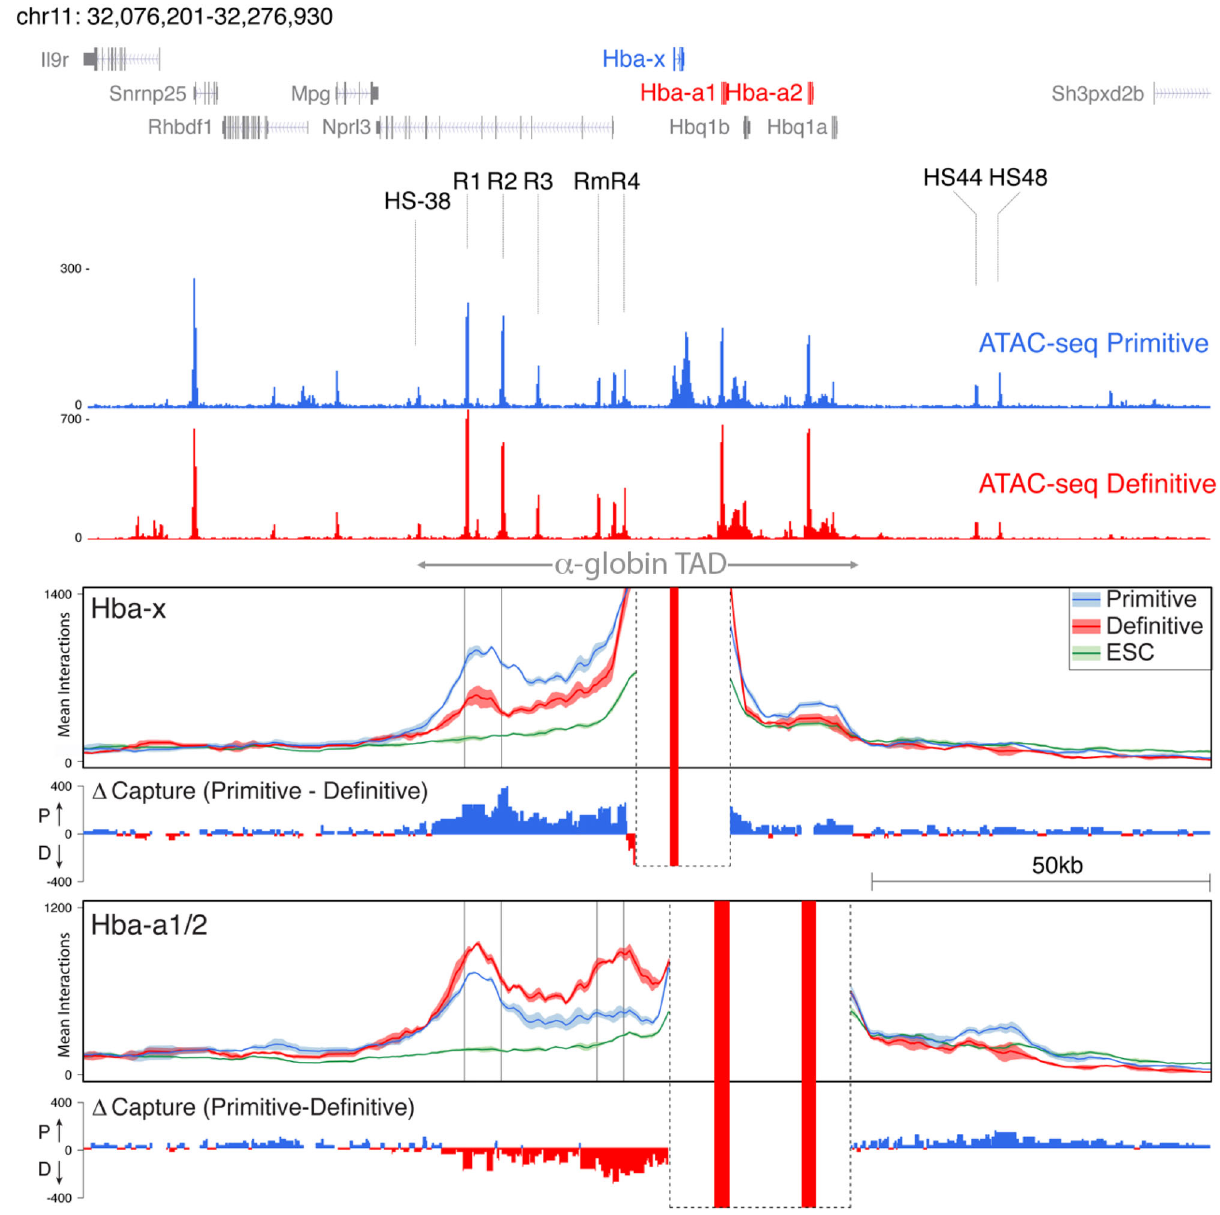
Fig. 4 The ζ -globin gene remains in proximity to the α -globin superenhancer in de fi nitive erythropoiesis. Normalized Capture-C data from the viewpoint of the Hba-x promoter and the Hba-a1/2 promoter (lower panels), ATAC-seq tracks are shown above for orientation. The mean, plus and minus one standard deviation (s.d.), of sliding 5 kb windows are visualized. Differential tracks ( Δ Capture-C) show a subtraction (Primitive − De fi nitive) of the mean number of meaningful interactions per restriction fragment. Red vertical bars indicate the position of viewpoints; an ATAC-seq track from primitive erythroid cells is shown with the enhancer elements, promoters, and CTCF boundary elements denoted. Data from three independent experiments are merged. The extent of the alpha-globin TAD is indicated with a double-headed